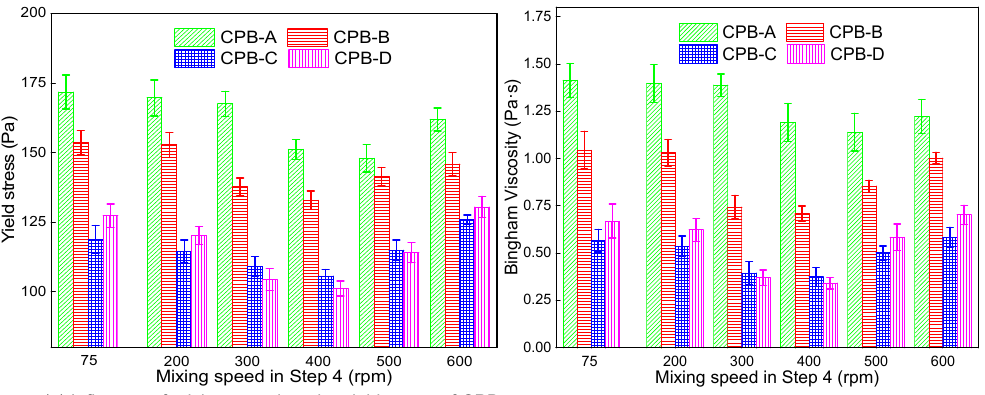
Figure 8. Influence of mixing speed on the yield stress ( a ) and Bingham viscosity ( b ) of CPB.